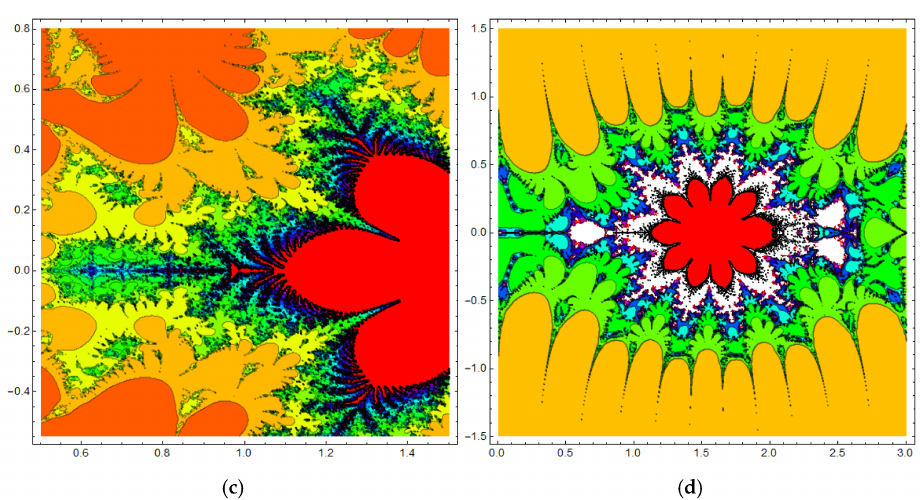
Figure 6. The Mandelbrot sets generated by the generalized fractional cosine map at α = 0.3, where